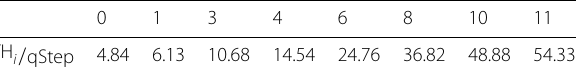
Table 1 Example thresholds obtained for a 16 × 16 block ( β = 3, ρ = 0.6)